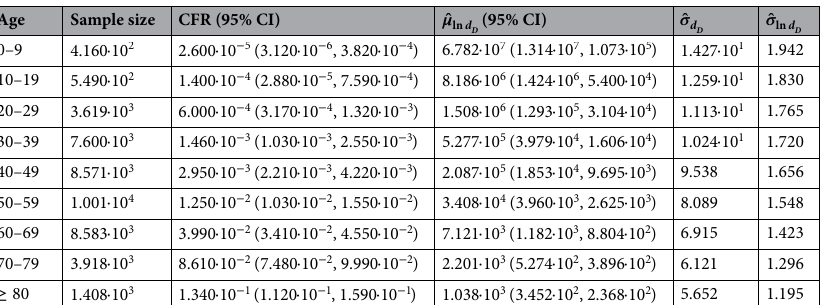
Table 1. Age-dependent case fatality rate (CFR) parameters. The number of days from onset to death d D is assumed to be lognormally distributed. The CFR (95% CI) and sample size for respective age categories are obtained from 49 . The reported CFR values are taken as the CDF of an exponential distribution with mean rate at day 41. The computed d D is then taken as the median of the associated lognormal of occurrence 1 d D distribution, from which the parameters of the associated normal distribution, ̂𝜇 ln d